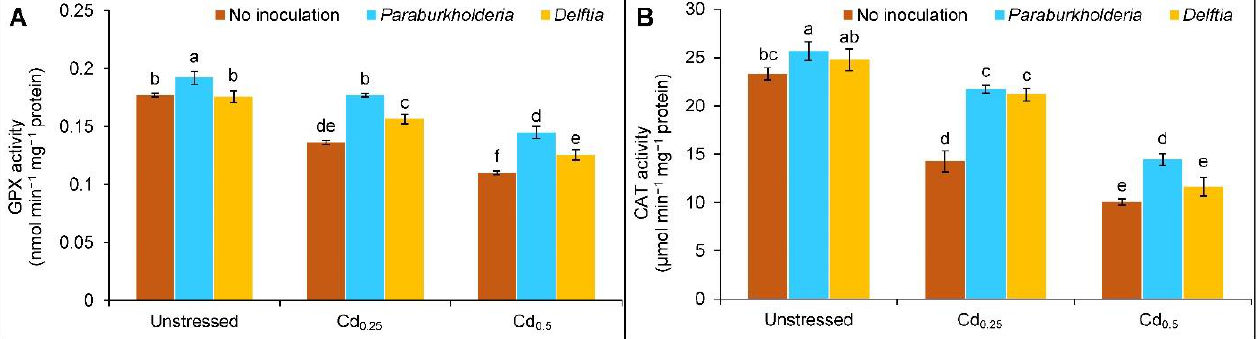
Figure 5. Effect of Paraburkholderia fungorum and Delftia sp. on the activity of ( A ) glutathione peroxidase (GPX) and ( B ) catalase (CAT) of rapeseed under different levels of CdCl 2 . Here, Cd 0.25 and Cd 0.5 indicated 0.25 and 0.5 mM CdCl 2 , respectively. Different letters on the bars indicate statistical significance at 5% levels of probability following Tukey’s HSD test and the mean (±SD) values obtained from three replications.